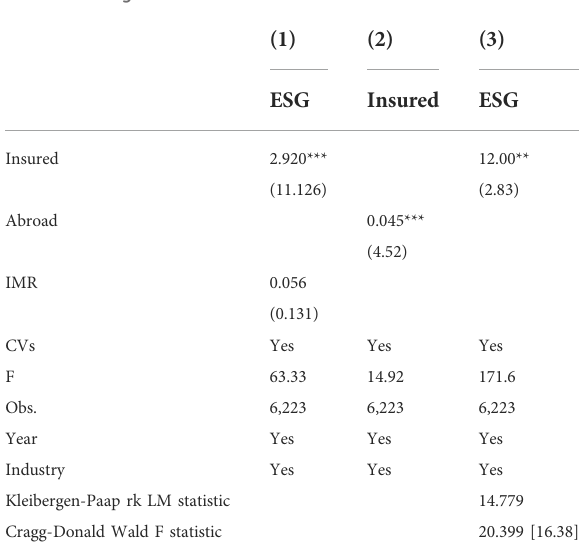
TABLE 3 Test for moderating